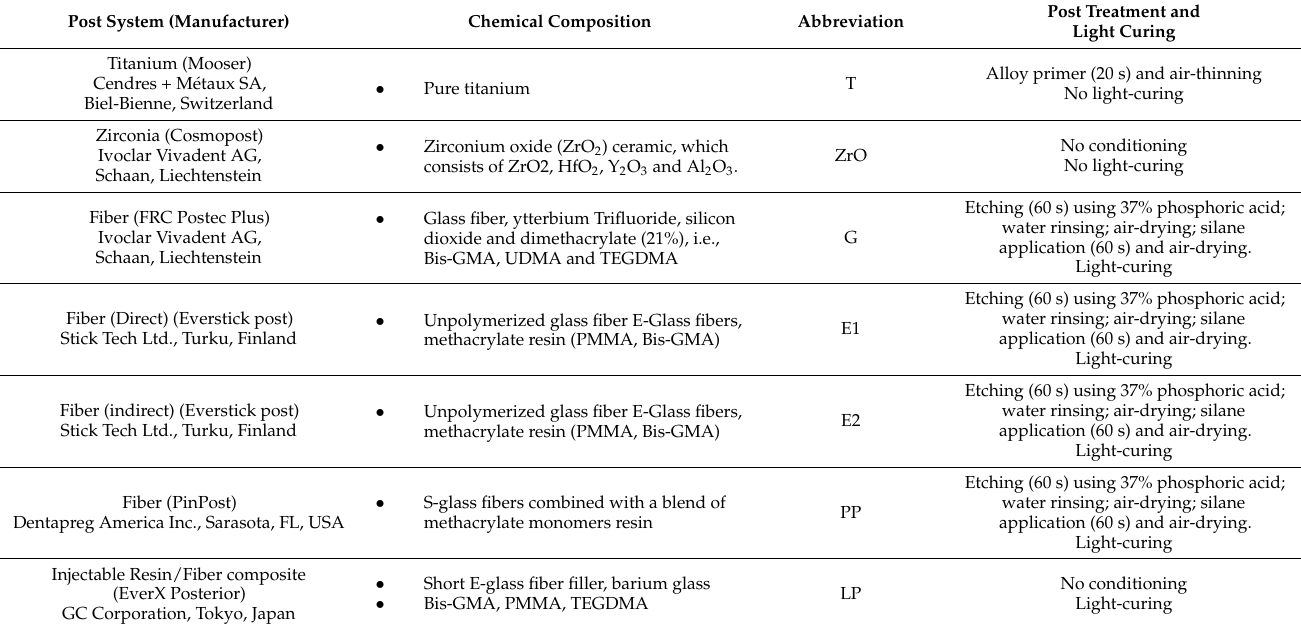
Table 1. Post systems used in this study and their chemical